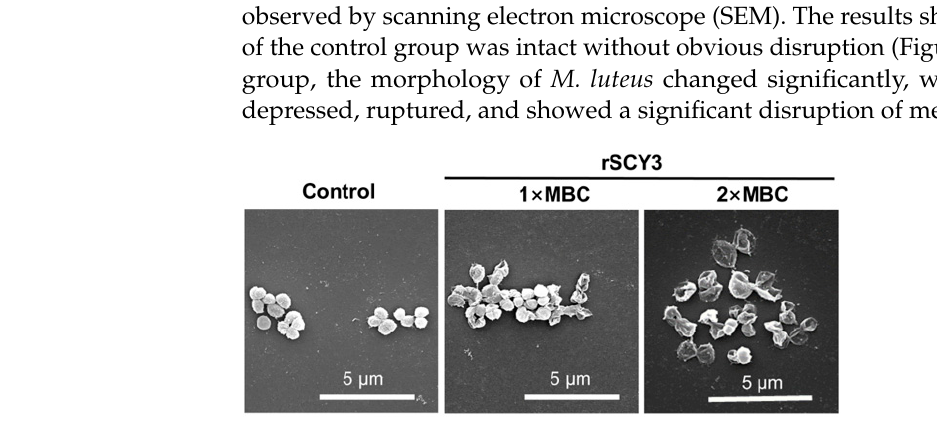
Figure 3. Effect of rSCY3 on morphology of M. luteus .